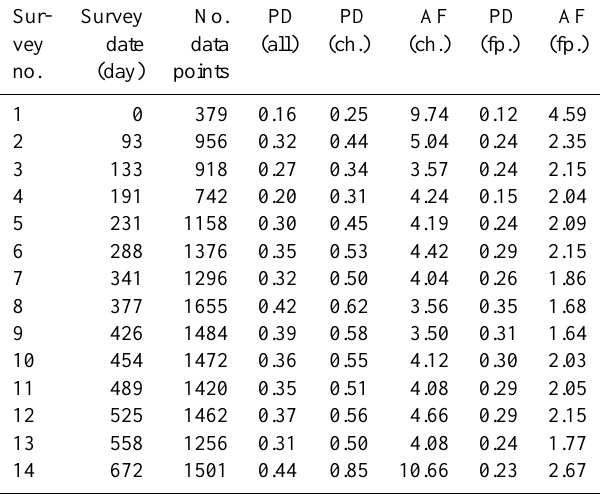
Table 1. Overview of all morphological measurements, with point density (PD, points m − 2 ) and anisotropy factor (AF) as used in the interpolation routine, specified for the channel (ch.) and floodplain (fp.) areas, respectively. Sur-